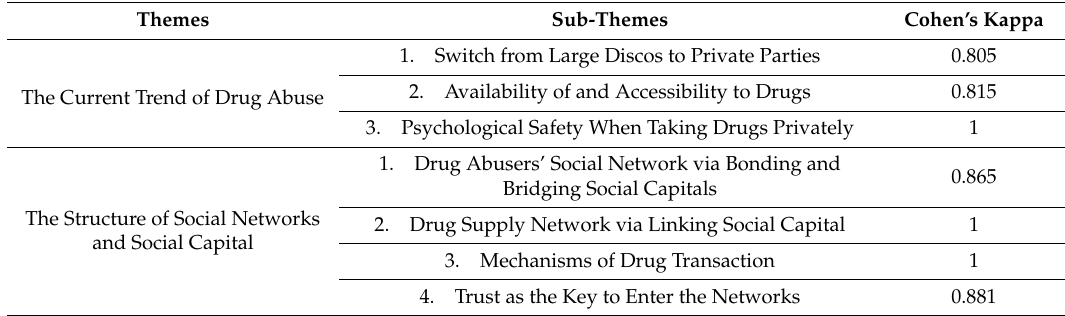
Table 3. Themes and